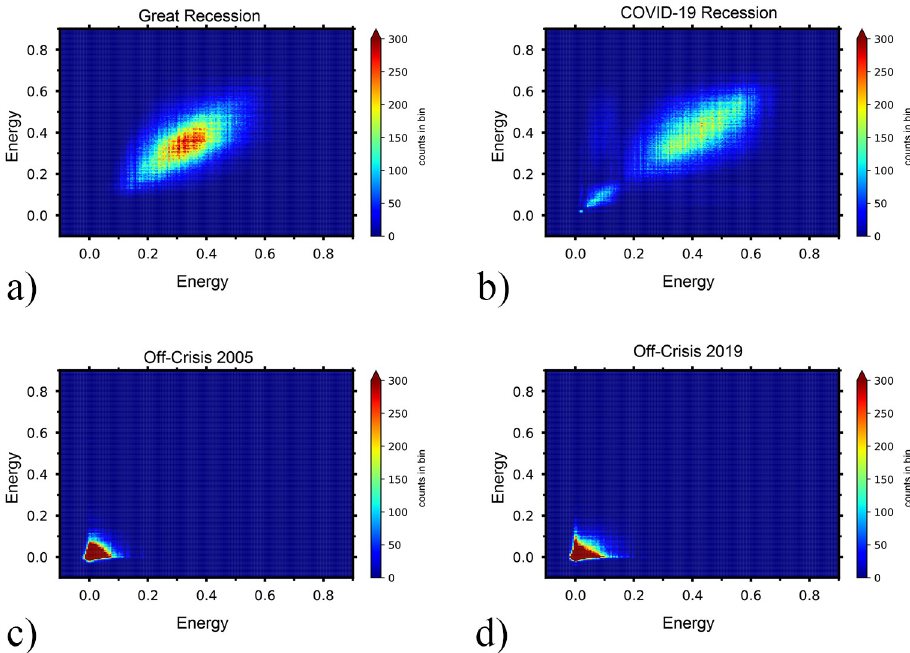
Fig 5. The pattern of energy-energy landscape between triads with one shared link. The upper row shows the energy-energy landscape for a) the Great Recession and b) the COVID-19 recession. The lower row is the energy- energy landscape for two off-crises periods c) July 28, 2005- October 6, 2005, and d) November 15, 2018 –January 30, 2019. Each point is representative of the number of triangles with a common link which have the specified values of energies. In the on-crises periods, triangles with various energies are connected while in off-crises periods points are localized to small energies.